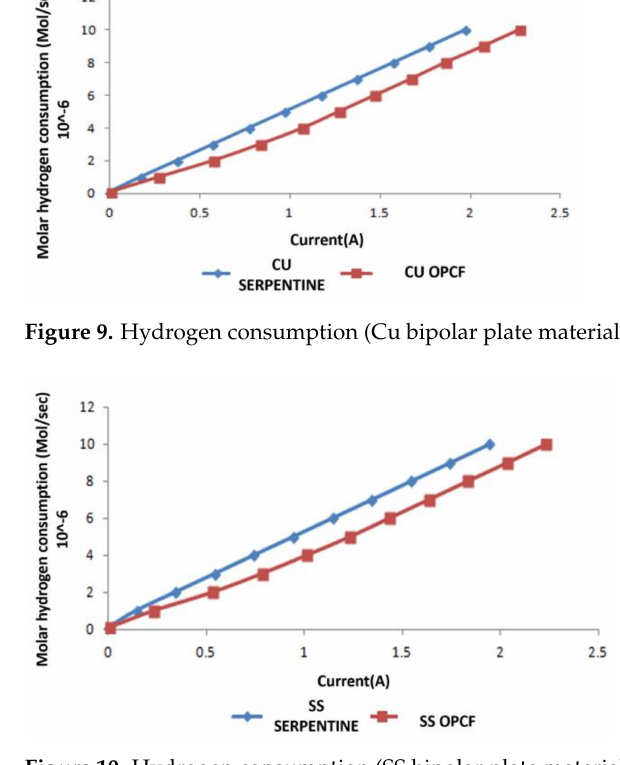
Figure 10. Hydrogen consumption (SS bipolar plate material).